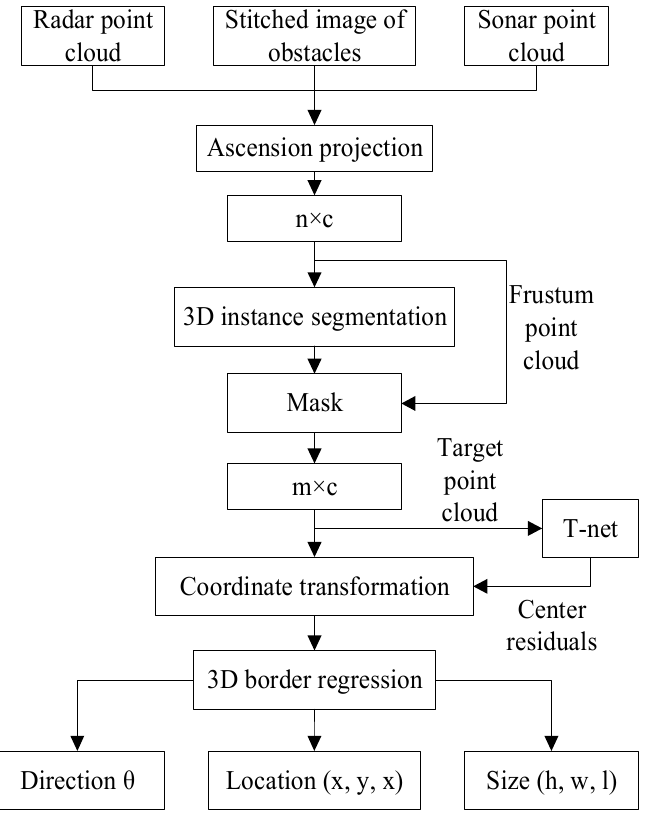
Figure 15. Flowchart of the image-driven Frustum–PointNet detection algorithm.